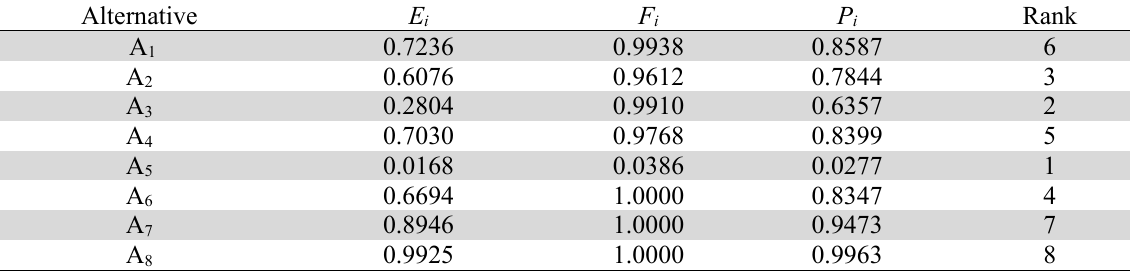
Ranking of material alternatives in modified VIKOR